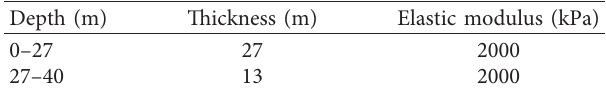
Sc: C = 0.07, ϕ = 32, ψ = 2, ϑ = 0.36, E = Figure 5: Geometry of the physical model. Table 5: Variation of elastic modulus of Tehran soil with